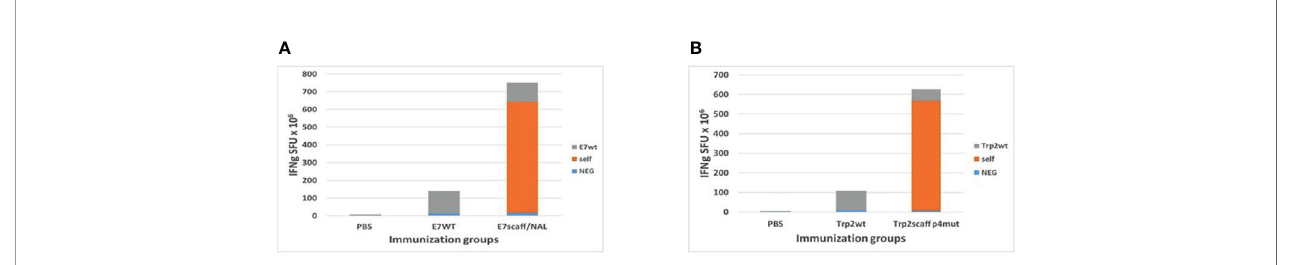
FIGURE 7 | Immune correlates in the immunization experiments with scaffolds. Spleens from sacri fi ced animals in HPV-E7 (A) and Trp2 (B) immunization groups were evaluated in an IFN g EliSpot assay after re-challenge with indicated peptides. Self = same peptide used in the immunization and in the re-challenge assay.